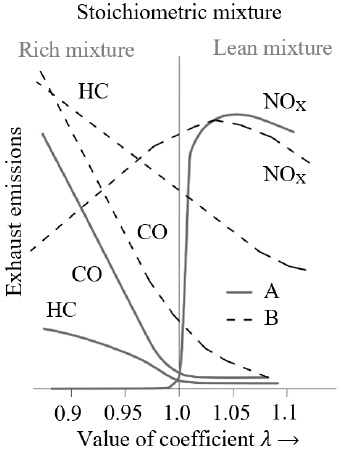
Figure 11. Flue gas emissions depending on the composition of the air-fuel mixture, where A: with flue-gas treatment system (three-functional catalytic system); B: without flue-gas treatment system; own analysis based on [79].